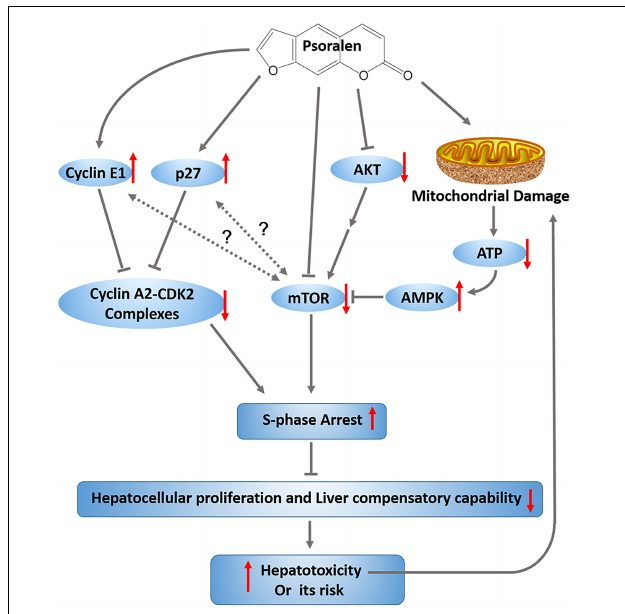
FIGURE 10 | Graphic abstract. The proposed mechanisms involved in psoralen-induced